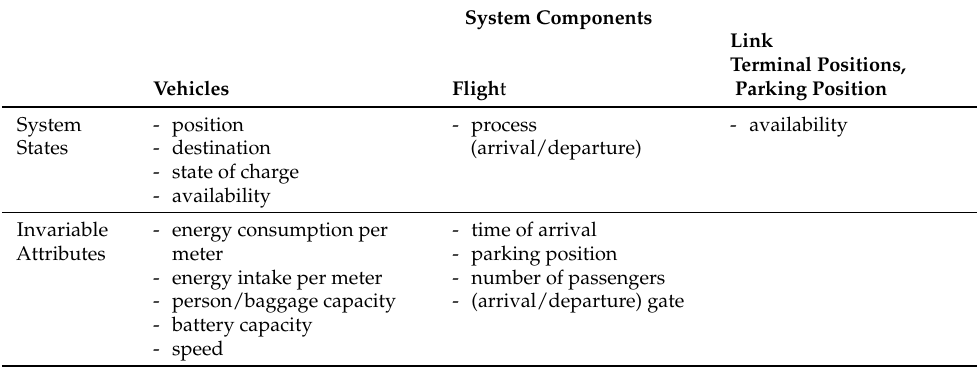
Table A1. Components of the simulation and their